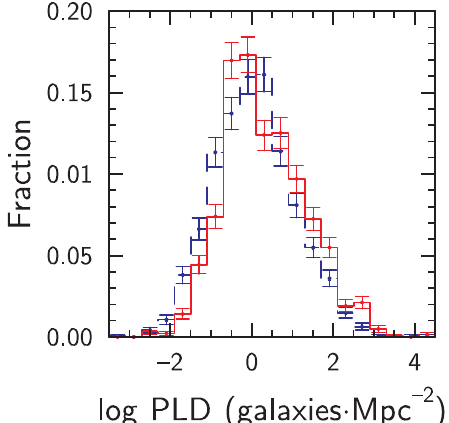
Fig. 6. Local density distribution for the pair subsample and new control sample with the same r p and ∆ V limits but with the requirement to have the same numbers of galaxies and the same redshift distribution as the pair subsample. Designations are the same as in Figure 1. in high density regions in comparison with galaxies without close